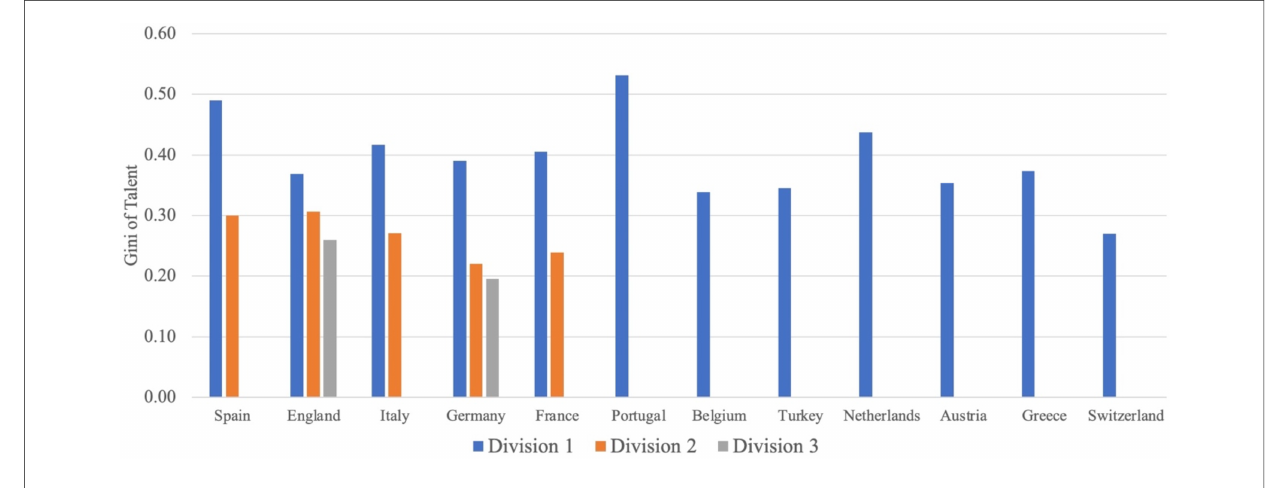
FIGURE 1 Talent concentration by country and division.